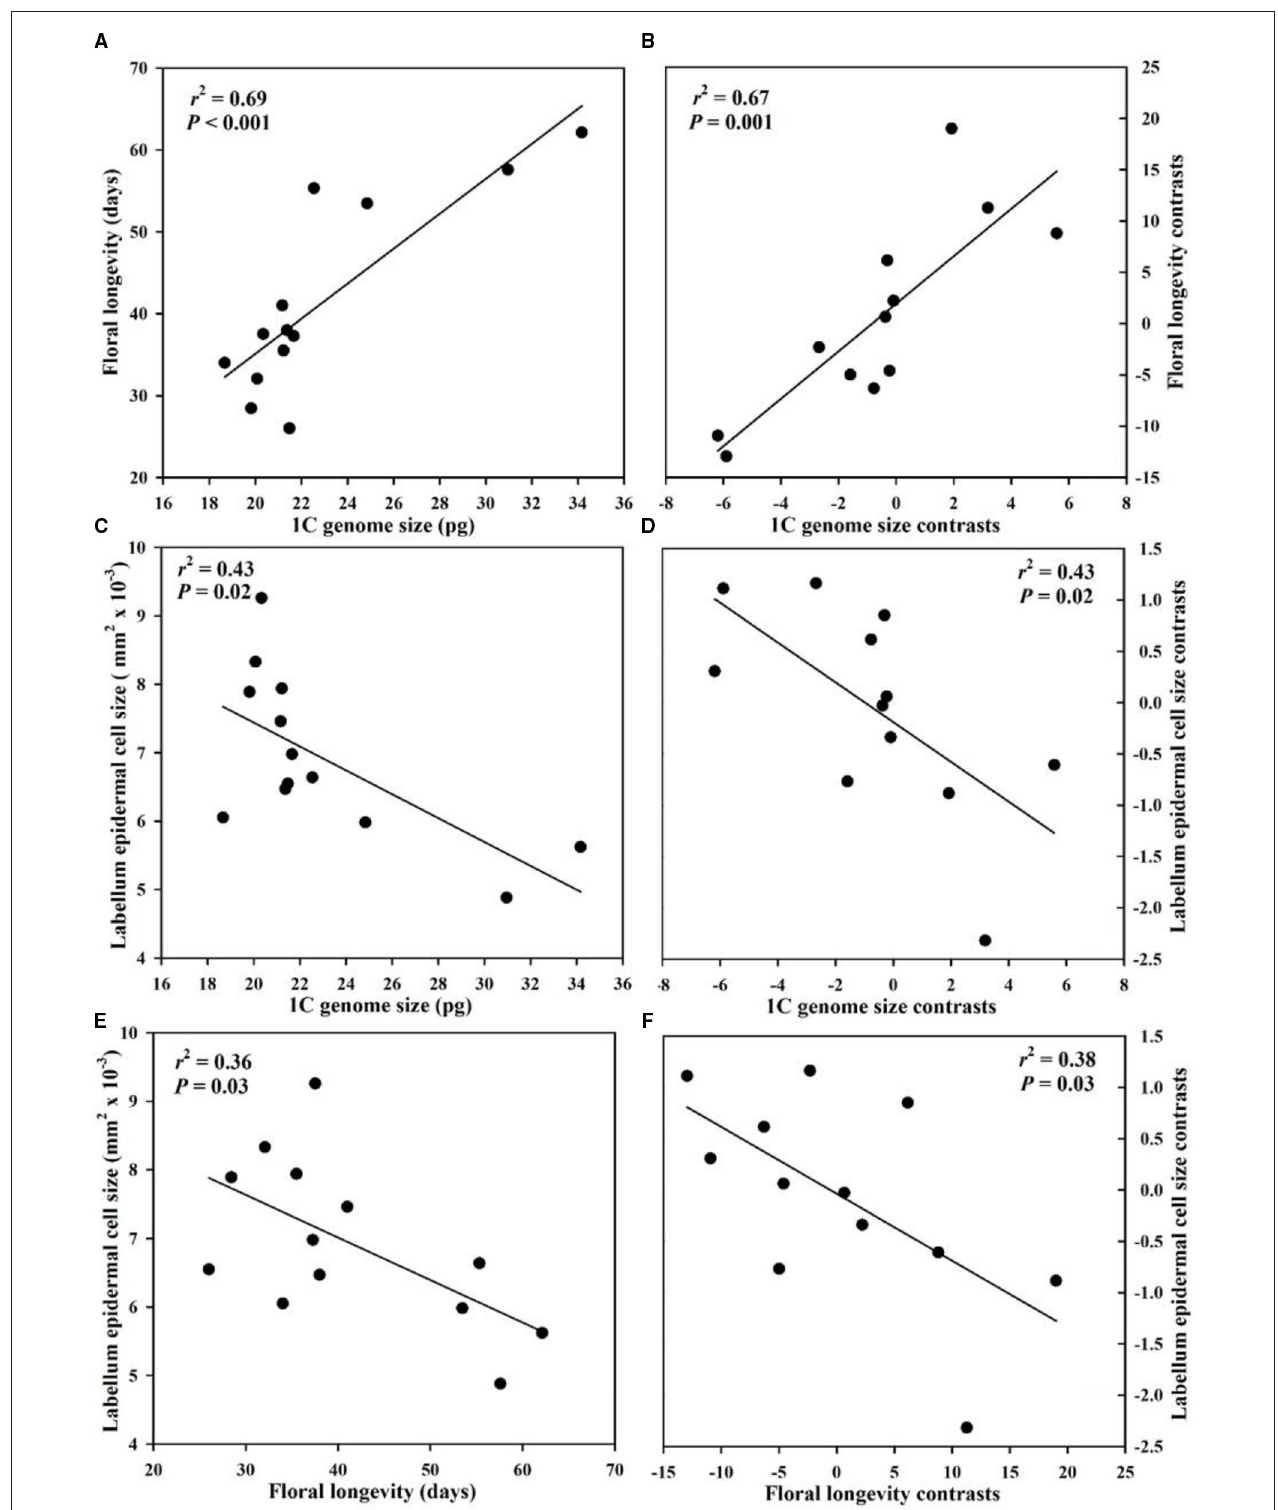
FIGURE 2 | Correlations among genome size, floral longevity, and labellum epidermal cell size from 13 Paphiopedilum species. (A,C,E) Pearson’s regressions; (B,D,F) phylogenetically independent contrast correlations.